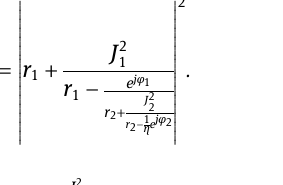
Figure 1: (a) Physical model of two coupled resonators. We mathematically treat two coupled resonators as two BSs and one mirror. (b) Structure of the coupled resonators composing a length-tunable air resonator and a length-fixed PDMS resonator. According to Fresnel ’ s ≈ 0 . 18 and r = n PDMS − n Air ≈ 0 . 17. (c) Hypersurface of Fabry – Pérot interferometer model, that is, non- formula, the calculated r 1 = n SiO2 − n Air 2 n SiO2 + n Air n PDMS + n Air modulated spectra. The black curve indicates that re fl ection varies with the parameters in resonator 2 when the length of resonator 1 is zero. The red curve indicates that the re fl ection escapes the hypersurface due to the photon coupling. (d) Envelope modulation depends on resonator 1 due to the photon